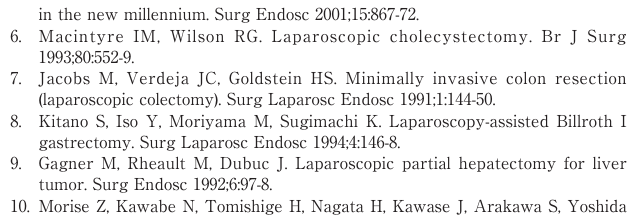
(B) In the laparoscopic approach (red arrows), the laparoscope and forceps enter the subcostal cage, and surgery is performed with minimal alteration and destruction of the associated